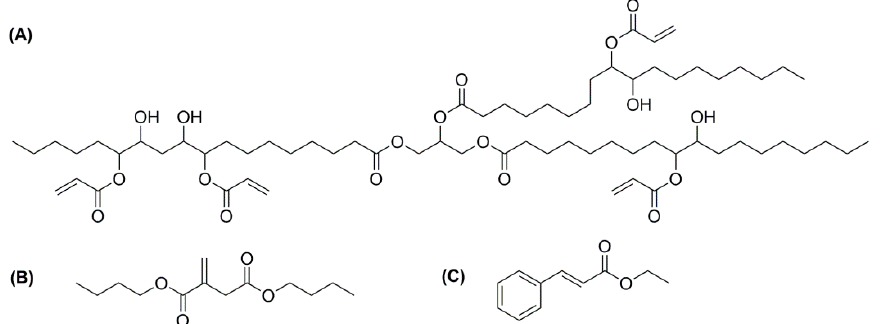
Figure 1. ( A ) Representative structure of acrylated epoxidized soybean oil (AESO); ( B ) dibutyl itaconate; ( C ) ethyl